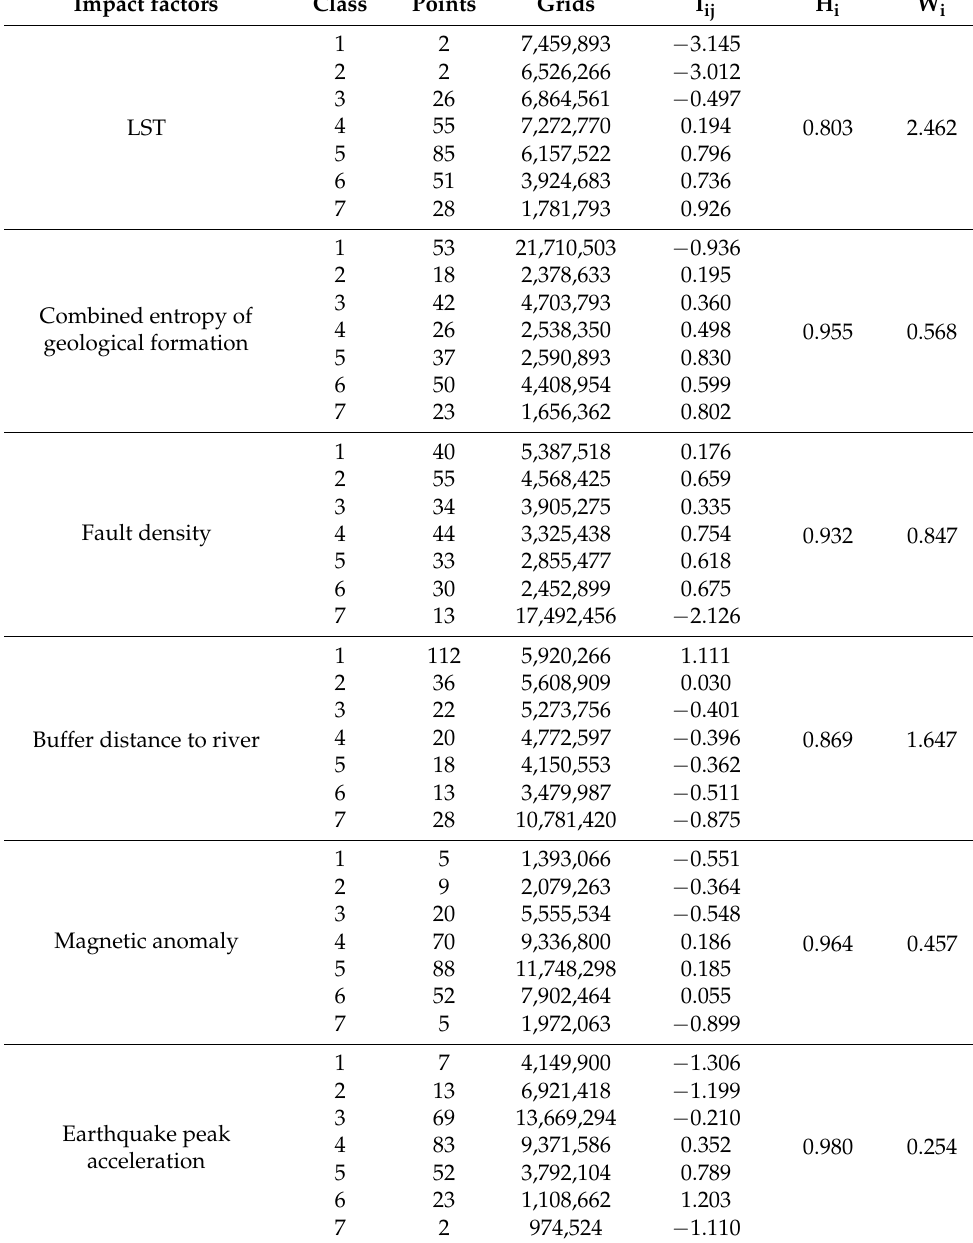
Table 4. Information values for impact